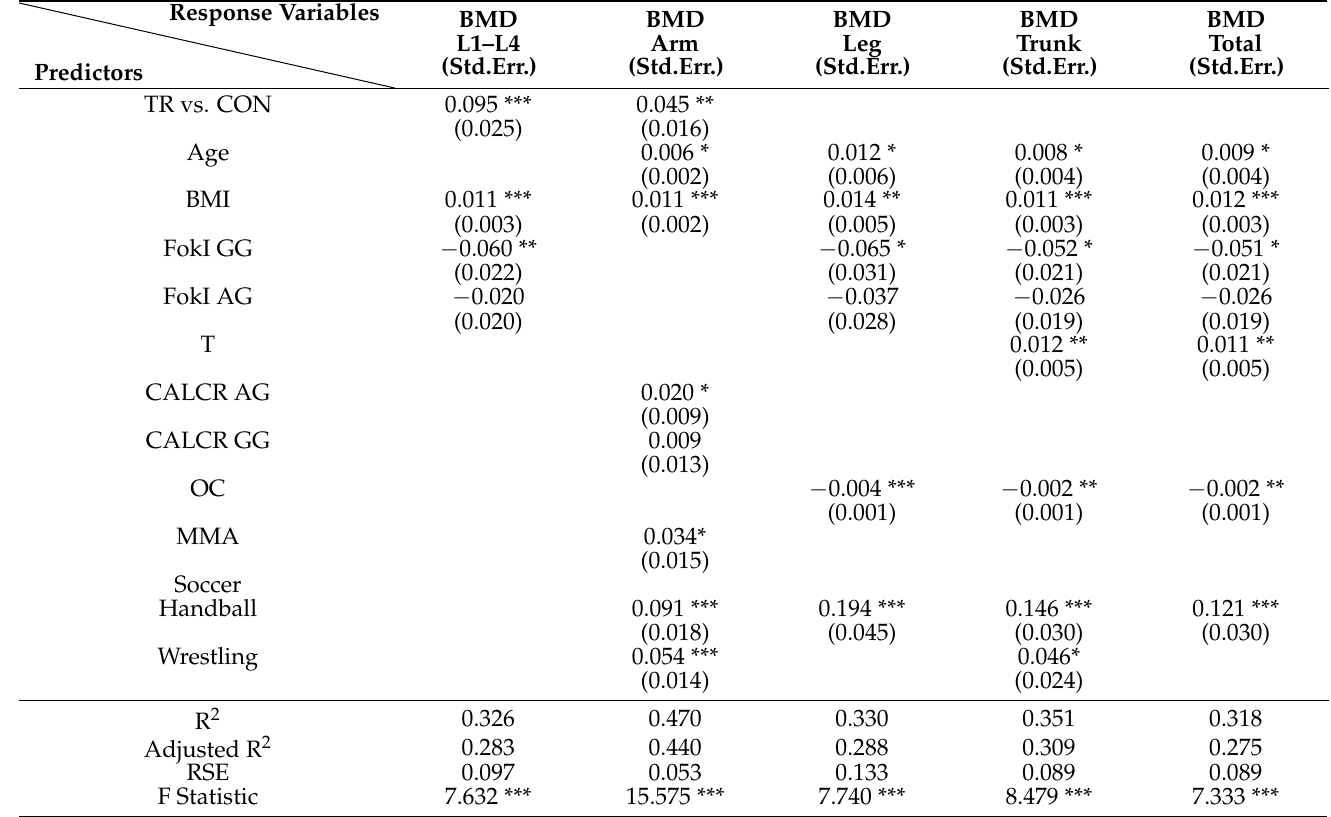
Table 5. Regression models of selected variables as predictors of